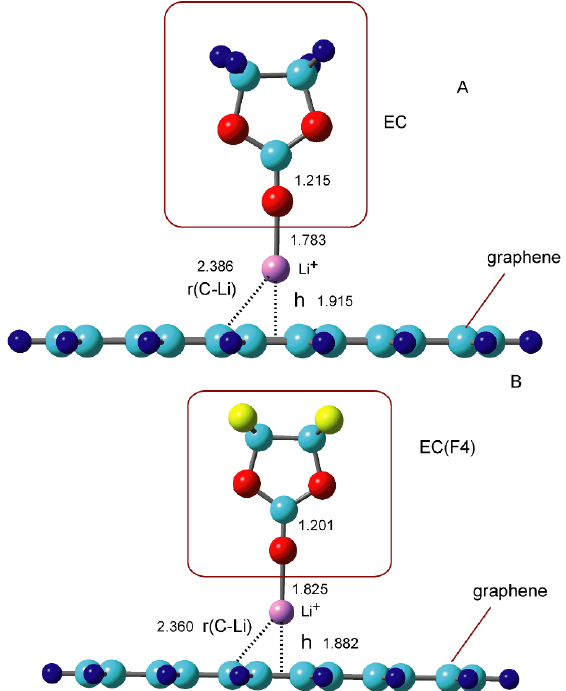
Figure 5. Optimized structures of EC ‐ Li + ‐ graphene ternary systems. Bond lengths are in Å. ( A ); Li + ‐ EC Complexes on Graphene, ( B ); Li + ‐ EC(F4) Complexes on Graphene.